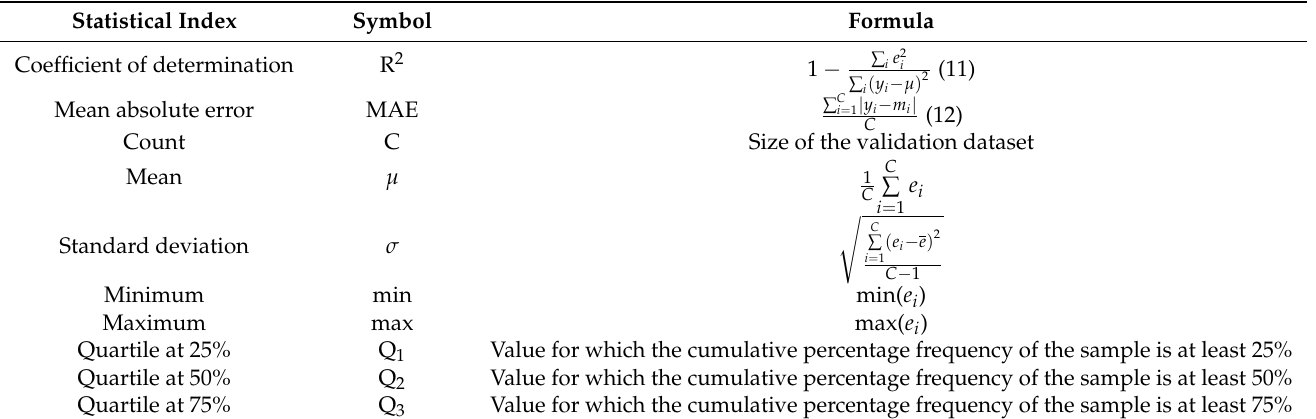
Table 8. Statistical quantities calculated on